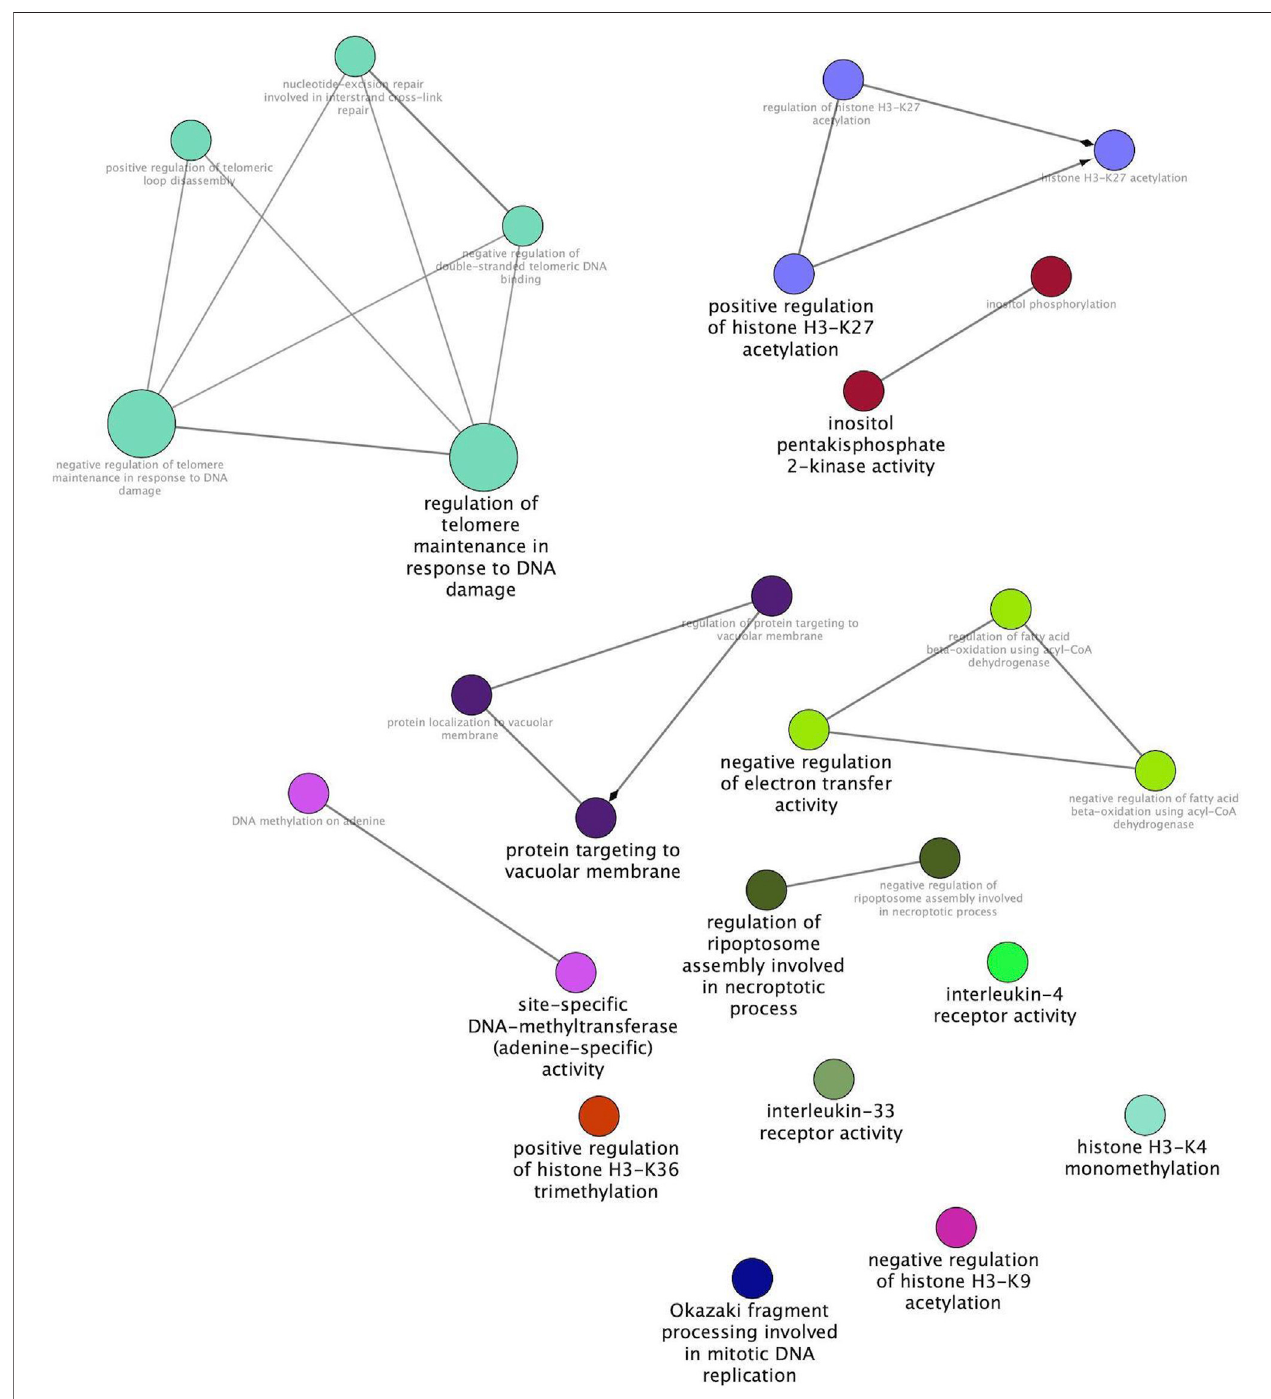
FIGURE 2 | Width module functional network. This image shows functional terms identi fi ed by ClueGO, considering genes belonging to the width module and whose mRNA level covaried with the breast width in normal and White Striping/Wooden Breast affected Pectoralis major muscles in 52-day-old broilers. Connections show how functional categories interact with each other. Terms belonging to the same functional group are colored with the same color. Black bold terms indicate the leading group term identi fi ed by the highest level of signi fi cance, using the Benjamini – Hochberg p -value and setting p < 0.05 as the signi fi cant threshold.